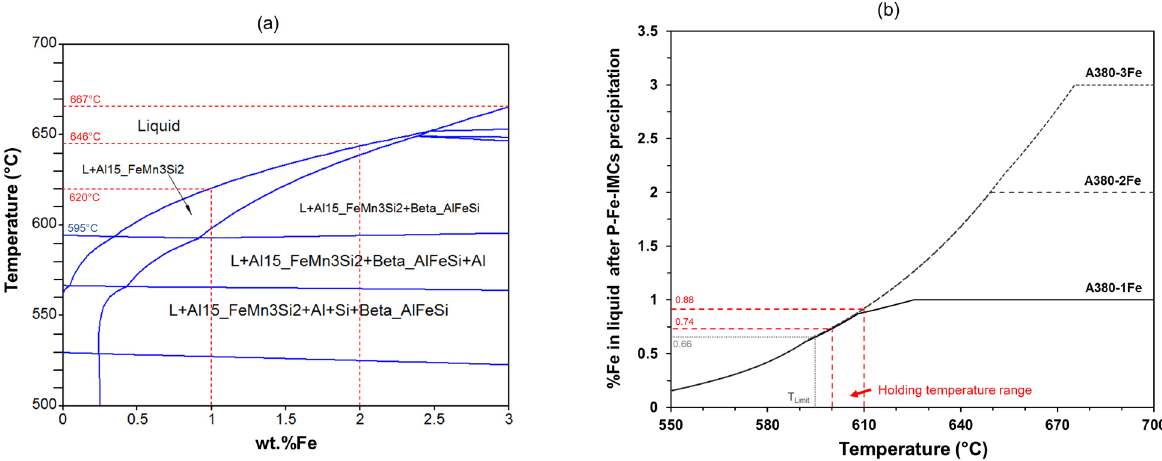
Figure 3. ( a ) Equilibrium phase diagram of the A380-0.2Mn alloy versus Fe; ( b ) level of Fe remaining in the liquid phase as function of temperature for three initial Fe levels as the P-Fe-IMCs form during solidification.